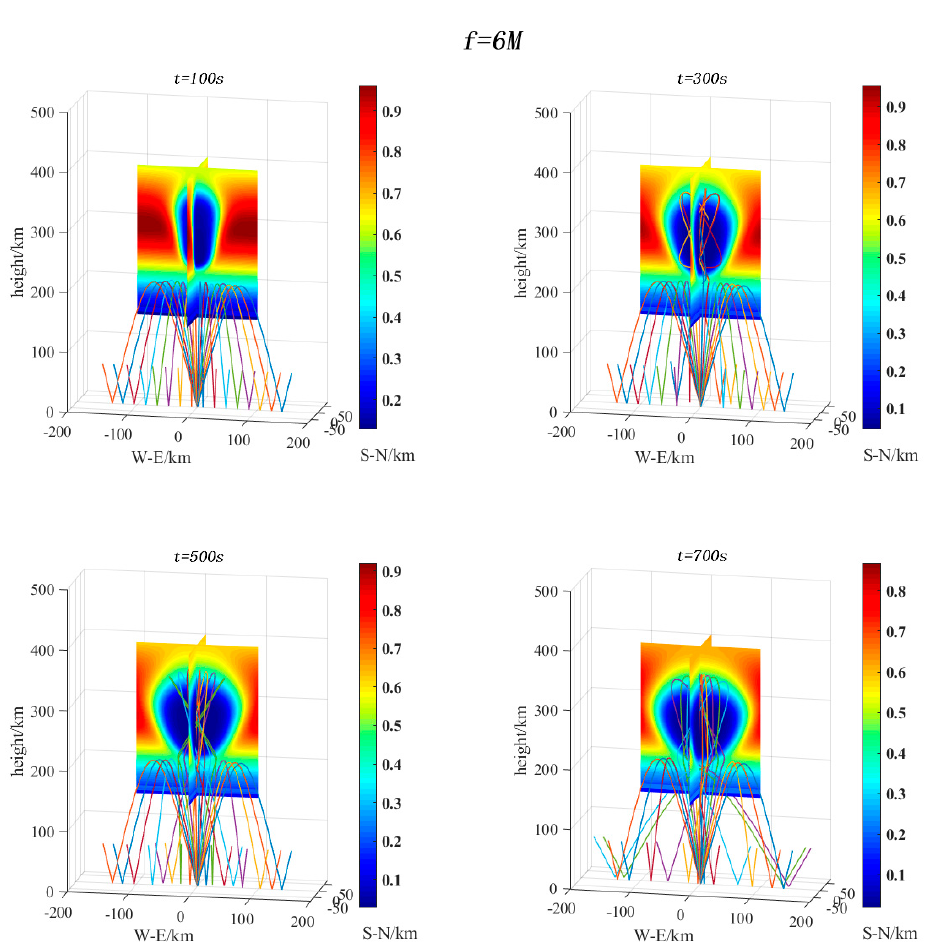
Figure 7. The 3D ray tracing simulation of 6 MHz shortwave echo path after CO 2 release of 100 s, 300 s, 500 s and 700 s (electron density unit: 10 6 cm − 3 ).